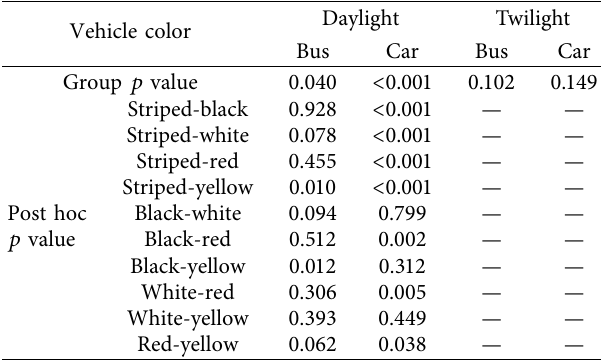
Striped-yellow 0.010 < 0.001